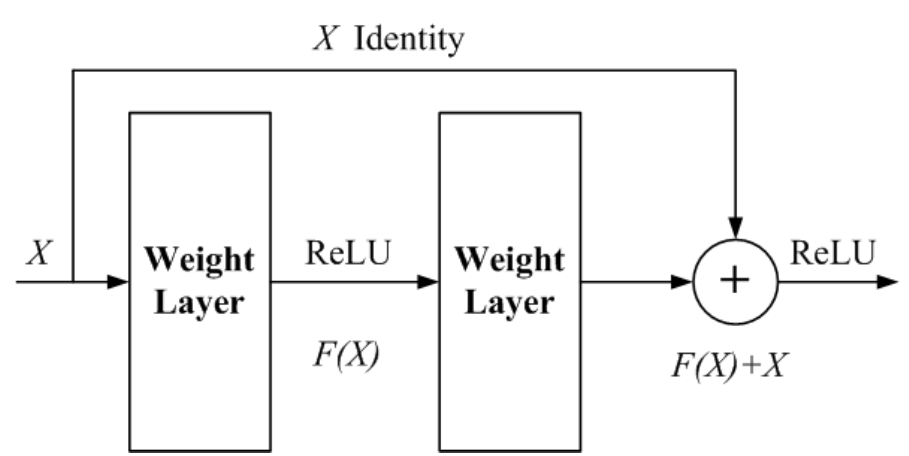
Figure 3. The structure of the residual